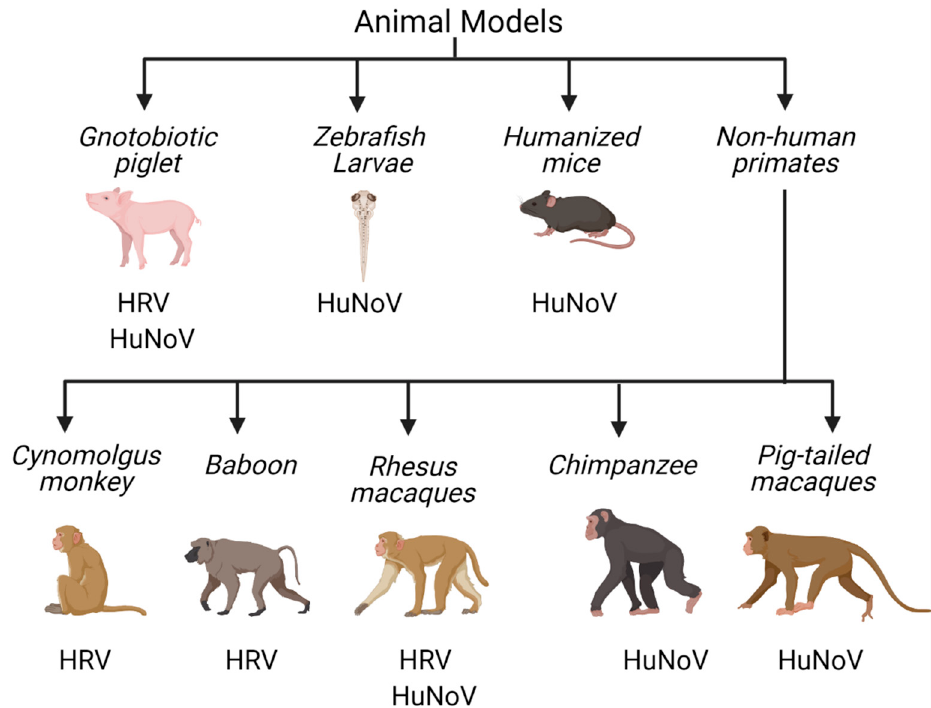
Figure 2. Animal models available for the study of HRV and HuNoV. Numerous animal models described to date support replication of HRV and HuNoV, including a variety of non-human primates as well as gnotobiotic pigs, zebrafish, and humanized mice. Created with BioRender.com (accessed on 21 January 2021).